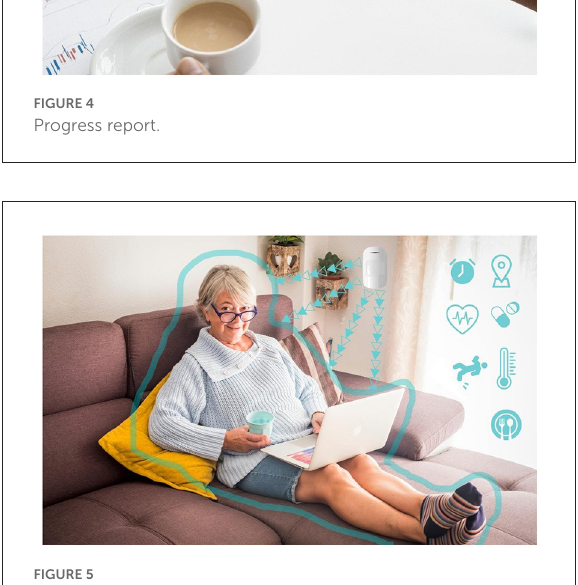
FIGURE5 We’ve got you